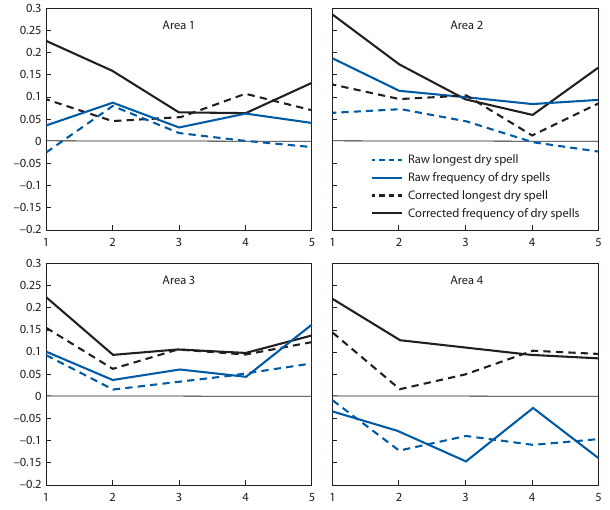
Figure 9. CRPSS as a function of lead time for the four areas in the Limpopo